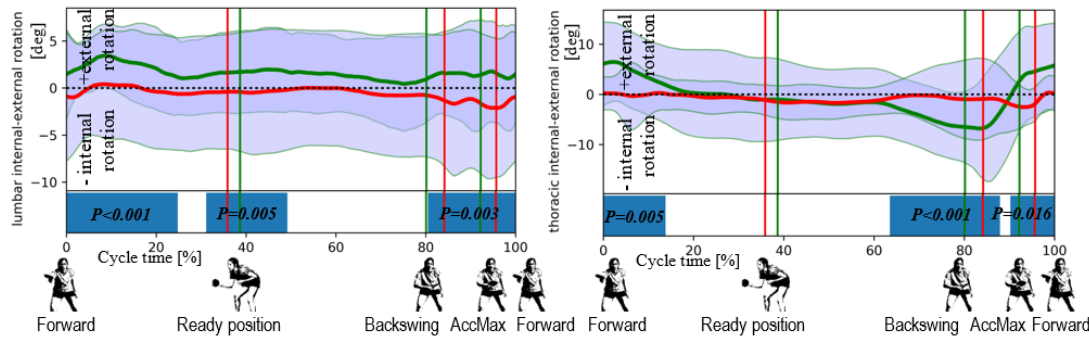
Figure 5. Differences in torso angular kinematics between female (in red) and male (in green) players revealed by the SPM for the lumbar internal-external rotation ( left ) and thoracic internal-external rotation ( right ). The statistically significant differences (for p < 0.05) are marked on the horizontal bar.